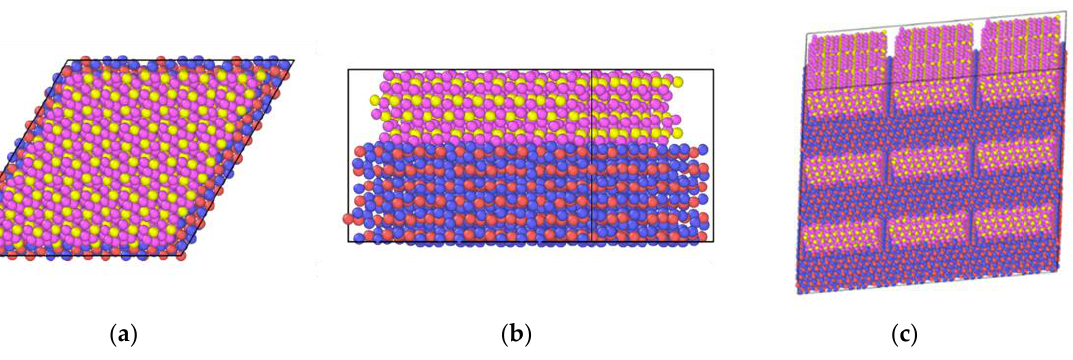
Figure 1. ZrO 2 (111) over In 2 O 3 (111): ( a ) top view, ( b ) front view, ( c ) ZrO 2 (111) over In 2 O 3 (111) with periodic structure replicated three times in each direction. Red is reserved for the In cations, with blue for oxygen in In 2 O 3 structure; pink is oxygen, with yellow for Zr cation in ZrO 2 slab.